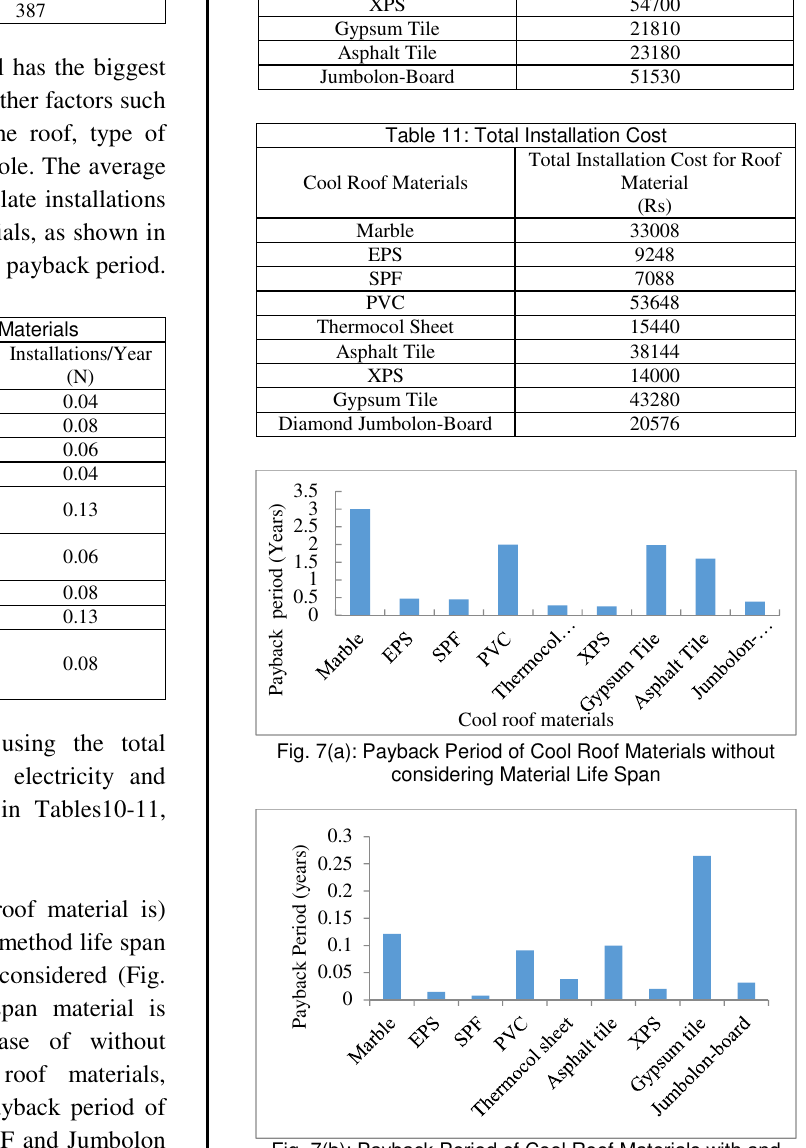
Fig. 7(b): Payback Period of Cool Roof Materials with and without considering Material Life